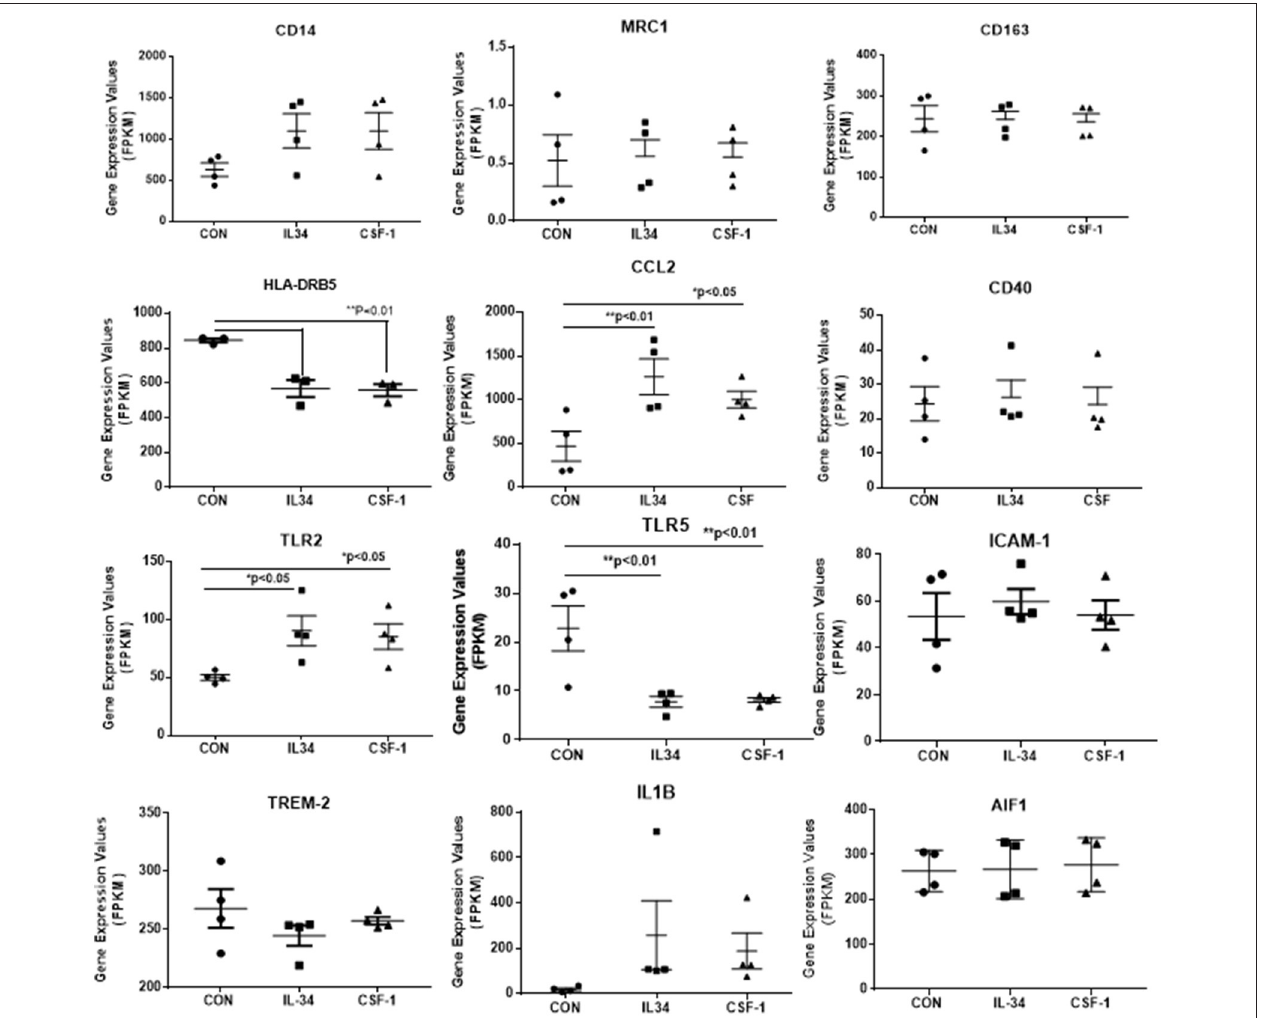
FIGURE 4 | Scatter plots showing levels of expression of transcripts (FPKM) of key markers of activation and function expressed in control, IL-34, and CSF-1-stimulated human brain microglia ( n = 4) for each treatment. Results were obtained by RNA sequencing. Due to the small number of cases, there was not statistically significant difference between groups in all cases, but many of the selected genes show trends for upregulation or downregulation of expression consistent with an altered phenotype of microglia. Data were analyzed by one-way ANOVA with Fisher LSD post-hoc test for between group significance. Bars on figures indicate mean ± standard error of mean (SEM) for each analyses. Significant changes were shown for expression of HLA-DRB5, CCL2, TLR2, and